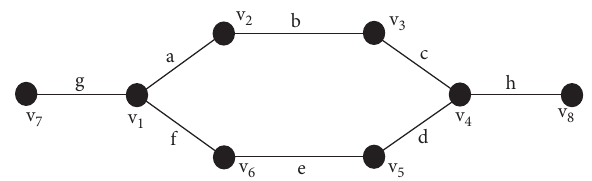
Figure 1: A graph with the e dim ( Γ ) � 2. Table 1: Edge distance codes of Γ w.r.t. A .